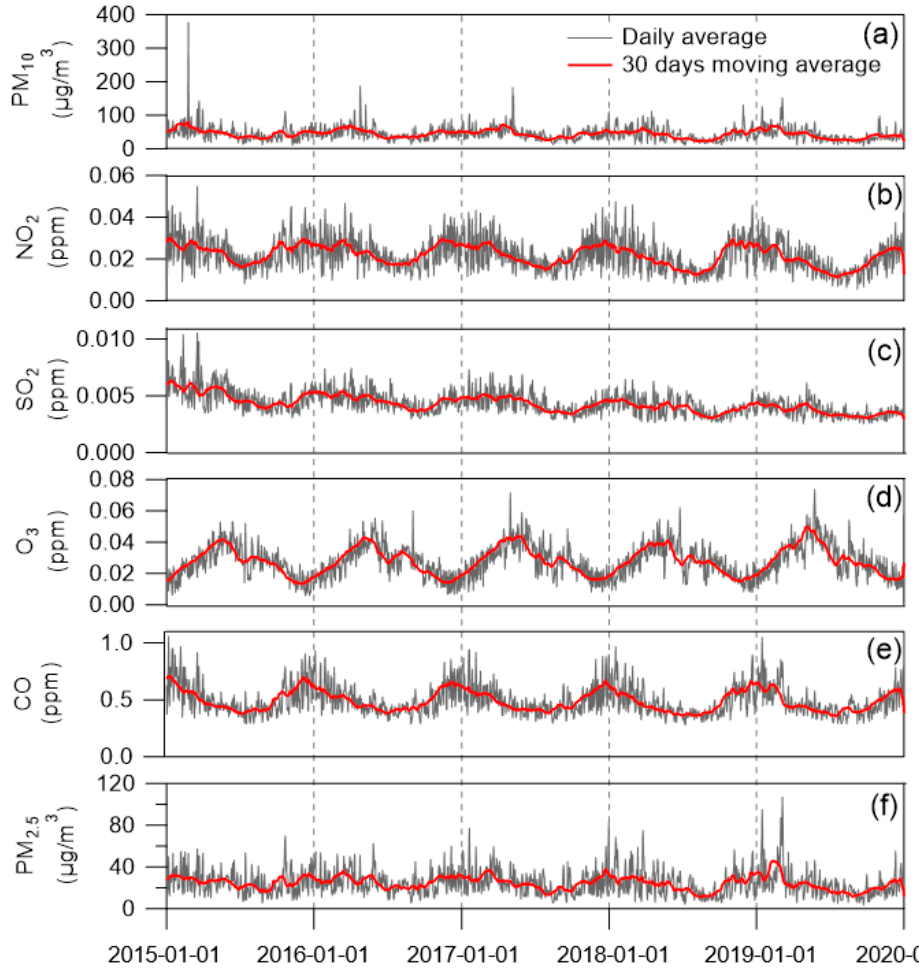
Figure 2. Daily average and 30 − day moving average for ( a ) PM 10 , ( b ) NO 2 , ( c ) SO 2 , ( d ) O 3 , ( e ) CO, and ( f ) PM 2.5 . and ( f ) PM 2.5